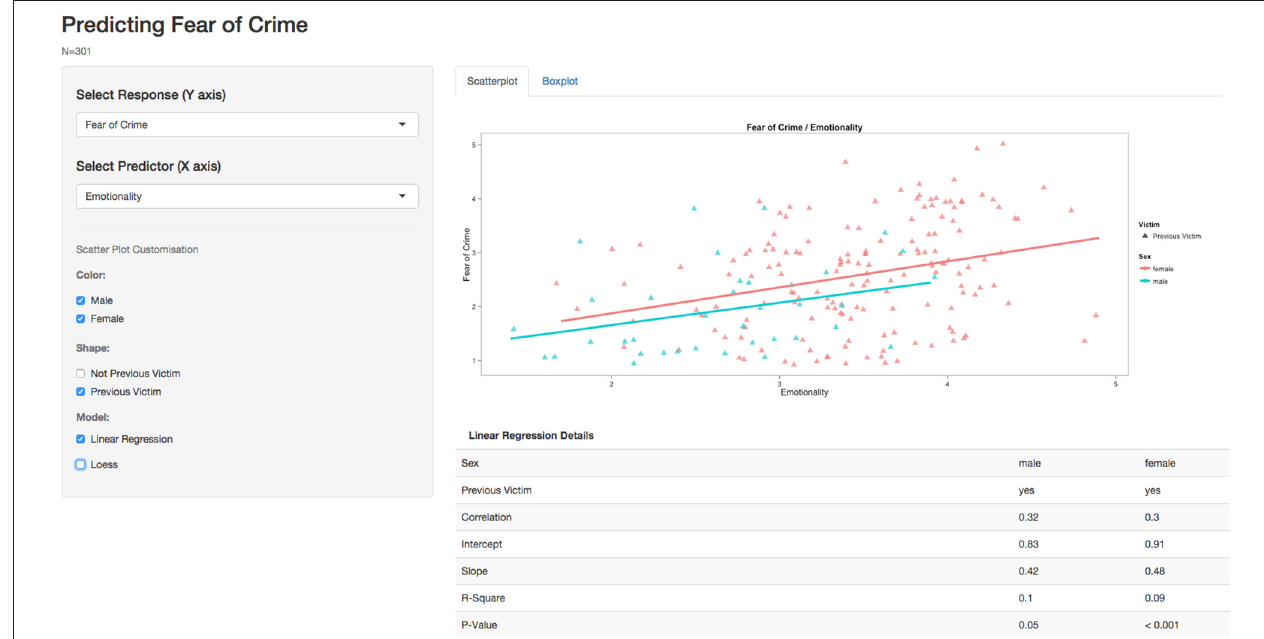
FIGURE 2 | Showing a variety of visualization options within Example